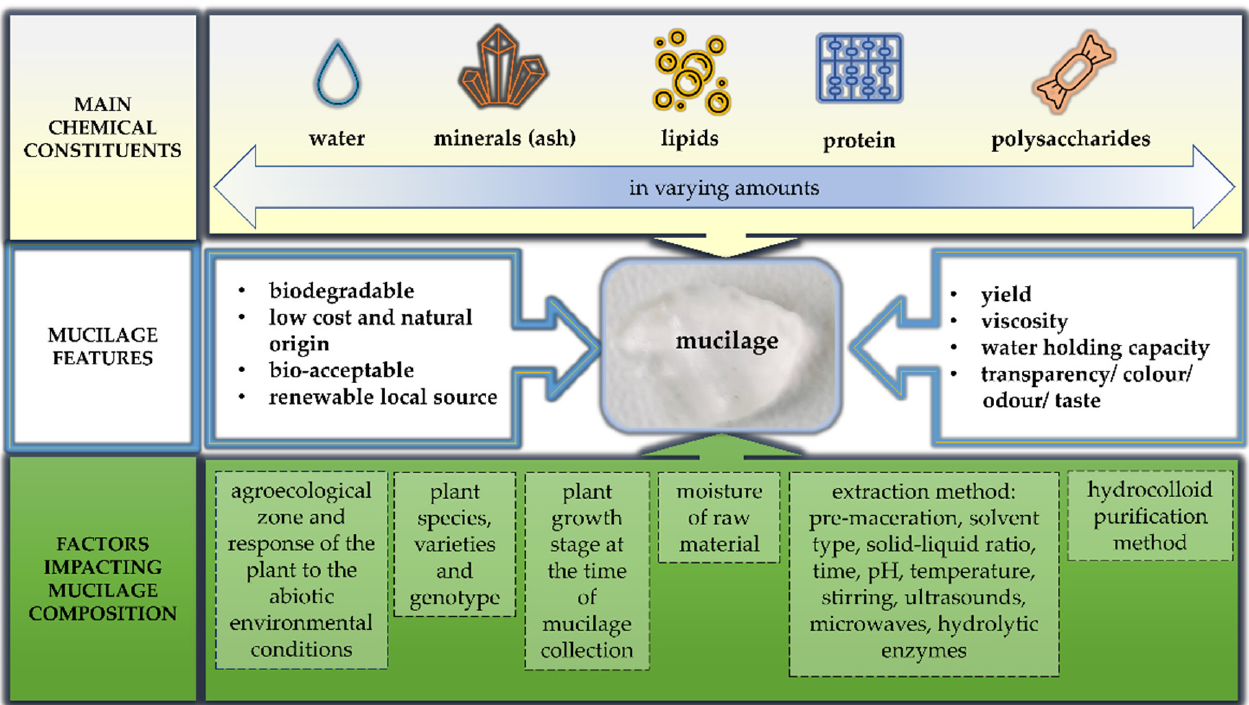
Figure 3. Parameters affecting the nutritional value and technological features of plant-derived mucilage.